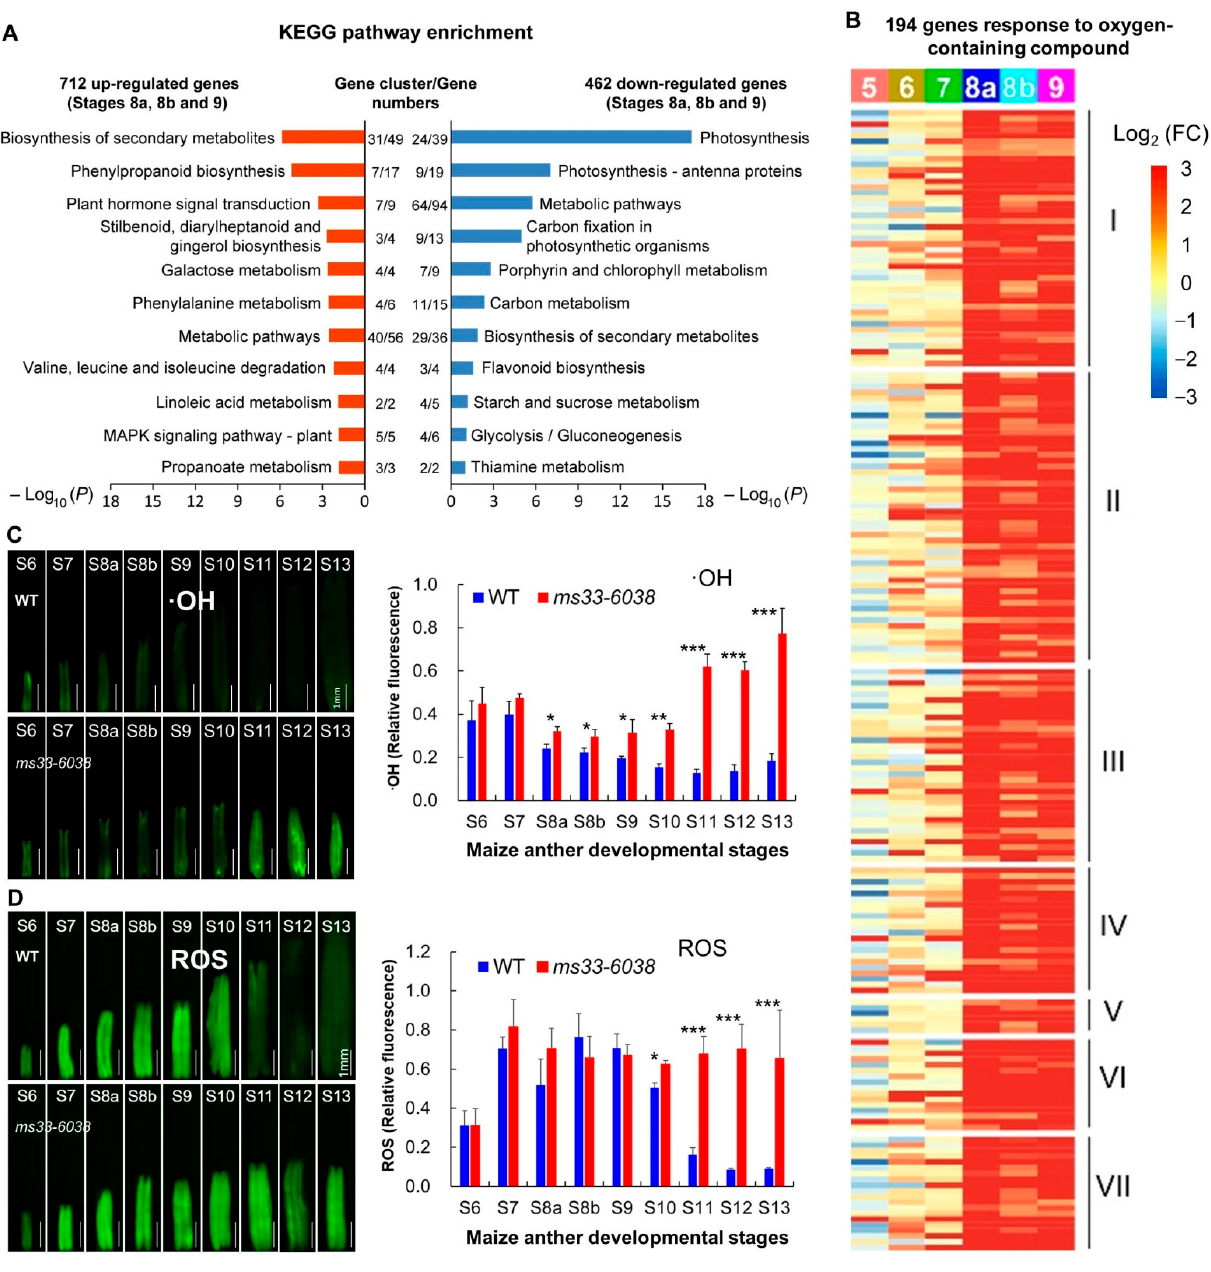
Figure 4. Active oxidative stress responses and increased ROS accumulation in ms33-6038 anthers. ( A ) KEGG pathway enrichment analysis of 712 upregulated and 462 downregulated genes between ms33-6038 and WT anthers from stages S8a to S9. ( B ) Expression changes of 194 genes related to the response to oxygen-containing component between ms33-6038 and WT anthers from stages S5 to S9. The 194 genes were functionally grouped into 7 types including ROS response (Table S3). FC, fold change. ( C , D ) Fluorescence imaging and relative quantification of the •OH contents ( C ) and the total ROS levels ( D ) in WT and ms33-6038 anthers from stages S6 to S13. * p < 0.05, ** p < 0.01, *** p < 0.001, Student’s t -test.